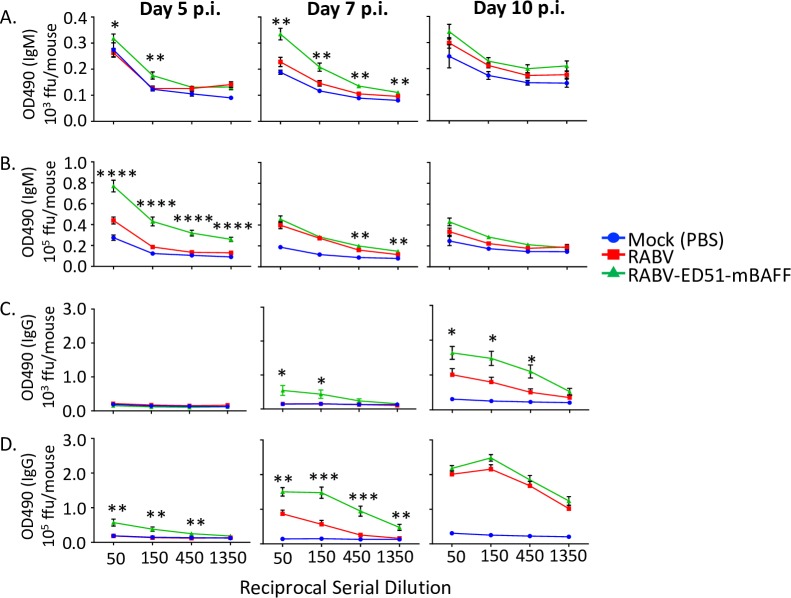
100-fold less RABV-ED51-mBAFF is needed to induce comparable immunity in mice immunized with RABV.C57BL/6J mice were immunized i.m. with 103 or 105 ffu/mouse of RABV or RABV-ED51-mBAFF, or PBS as a negative control. Blood was collected on days 5, 7 and 10 post-immunization as a source of serum. Four three-fold serial dilutions of sera were analyzed by ELISA to determine anti-RABV G IgM (A and B) or IgG (C and D) antibody titers and presented as OD490 of the reciprocal serial dilution. For comparison, sera from PBS-immunized mice were tested in parallel. Statistical difference in antibody titers by ELISA between RABV- and RABV-ED51-mBAFF-immunized mice was determined using an unpaired, two-tailed t test and data is presented as the mean ± SEM. *p≤0.05; **p ≤ 0.01; ***p≤0.001; ****p≤0.0001; N = 10 mice/group). (ffu = focus forming units; OD = optical density).